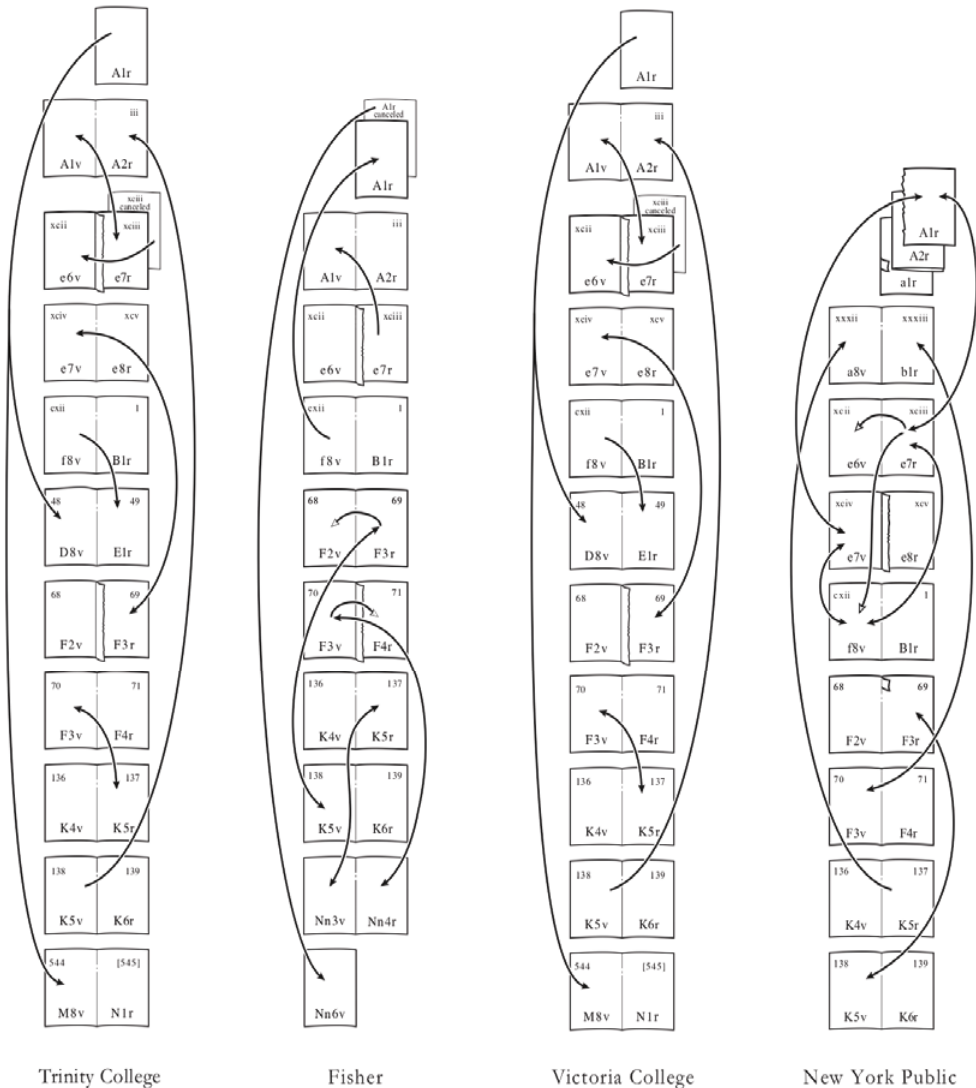
An arrow that originates from the head of another arrow and has itself a hollow head points to right -off set of a prior mirror -off set-a refl ection of a refl ection, a derivative of a derivative. Th ere are two examples each in Fisher and New York Public. In the latter copy, multiple arrowheads on A1r, e7r, e7v, and f8v suggest a variety of confi gurations of the battés over time. (Recall the multiple arrows to Q4v in the map of the Clark Library copy of the 1732 Paradise Lost on p. 141.) Because the original e7r set off on e6v in the Trinity copy, its early text survives en miroir across the gutter from the text that eventually replaced it. Th is copy thus archives the early and late stages of its production. Th at’s pretty neat. (In the Trinity copy, e7r cancellans bears no off set from e6v, but it does from A1v (I can’t at the moment say whether from the original A1 or from A1